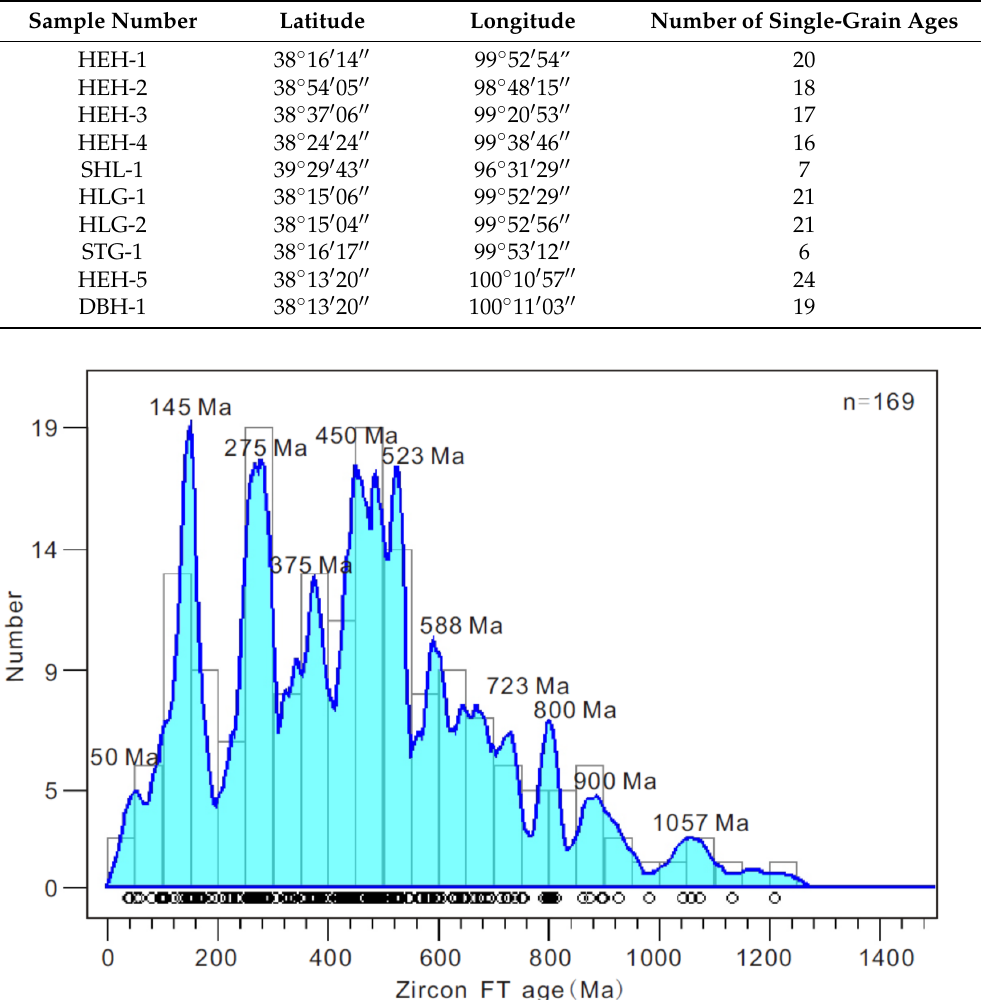
Figure 7. Kernel analysis histogram of all individual ZFT ages obtained from the Hei River. Calculated using the Density Plotter software (Version 8.5, Vermeesch, P, London, UK, https://www.ucl.ac.uk/ ~ucfbpve/densityplotter/, accessed on 25 February 2022) [104]. Raw analytical data are available as “Supplement Table S1” to this